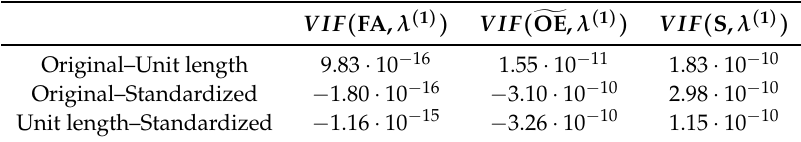
Table 4. Effect of data transformations on VIF associated with raise